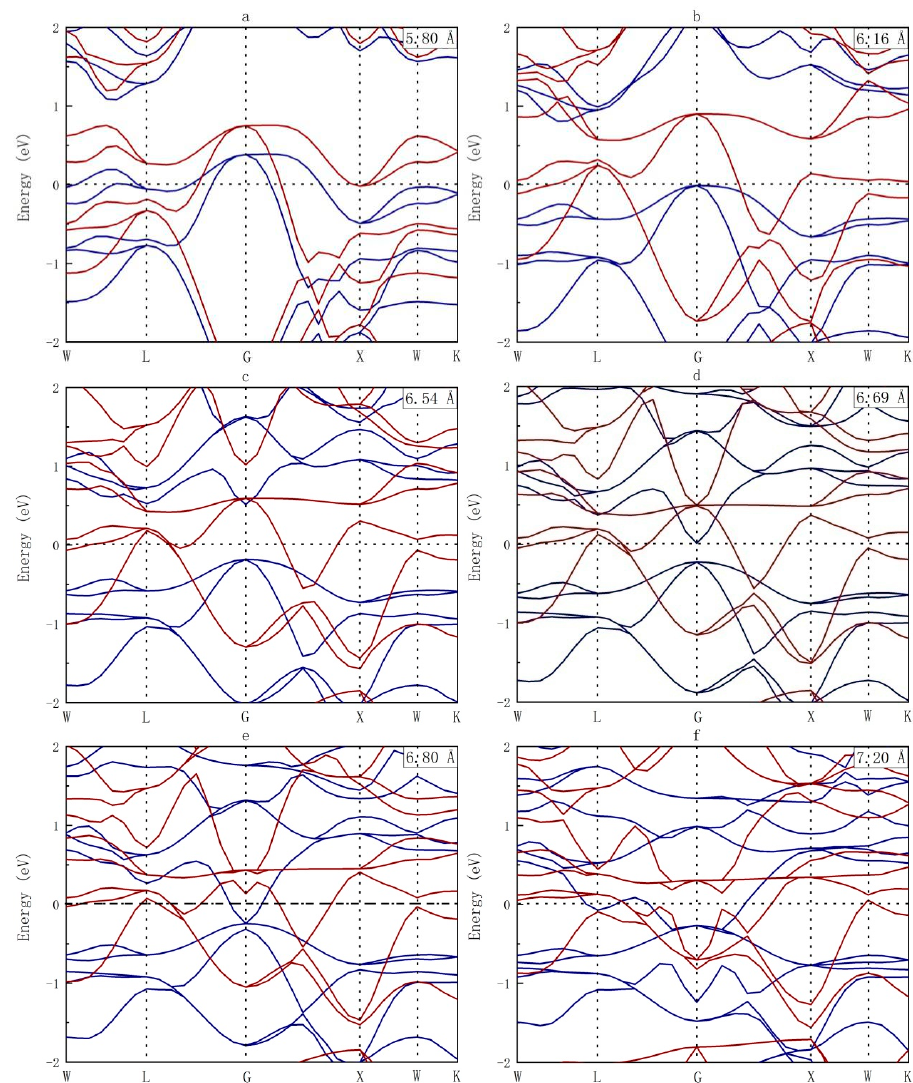
Figure 5. Band structures for the XA-type Sc 2 VGe at its uniform strained lattice parameters. The blue lines represent the spin-up channel. Crystals 2019 , 9 , x FOR PEER REVIEW